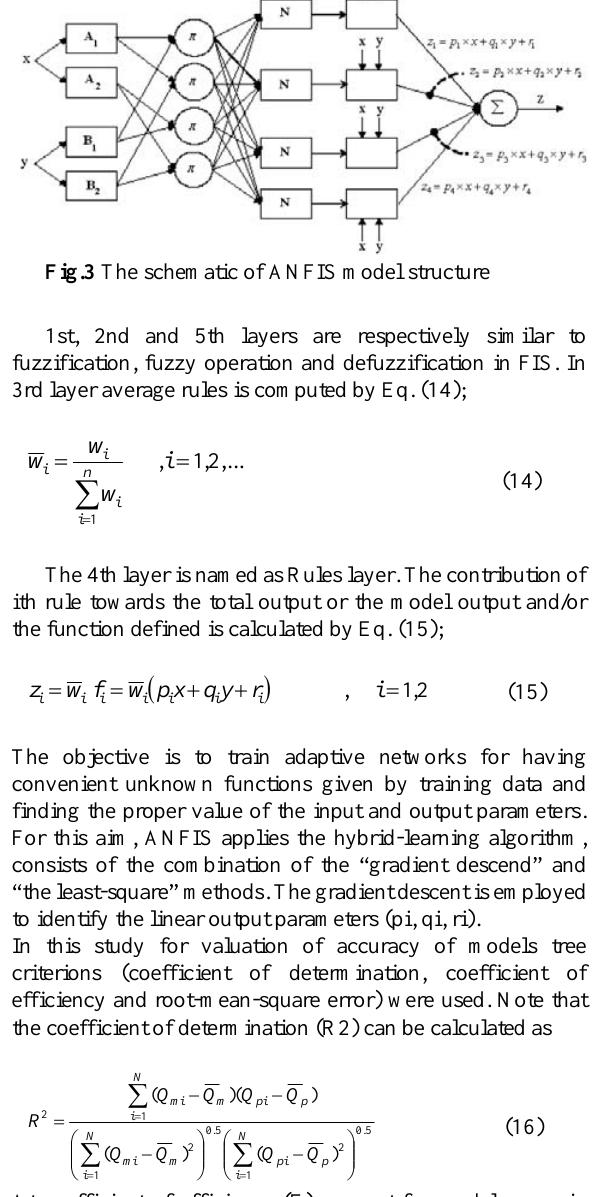
Table 1 Statistical characteristics of river flow